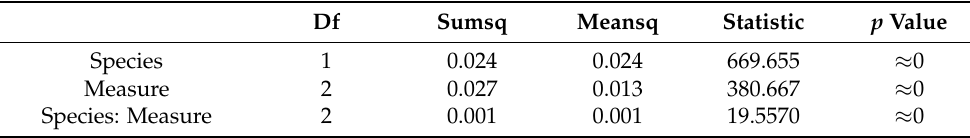
Table 3. ANOVA summary of species, measures and species: measures.